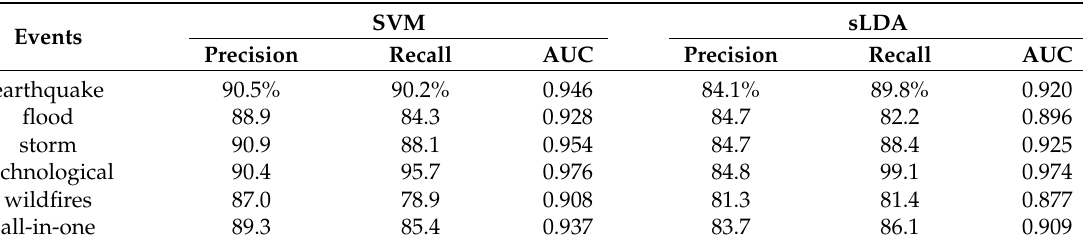
Table 2. Models quality by disaster categories.